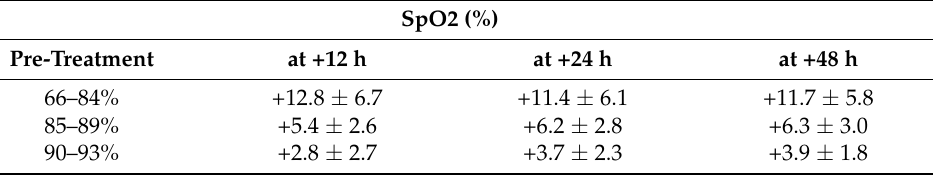
Figure 2. Pre- and post-treatment SpO2 values, all on room air, for 34 severe COVID-19 patients treated with IVM, doxycycline, and zinc. Graphs A–I are in horizontal groupings by the range of pre-treatment SpO2 values and in vertical groupings by elapsed time after first dose of IVM. (The lowest SpO2 value in the stipulated range of 51–93% was 66%.) For these elapsed times of x = 12, 24, and 48 h, the SpO2 value shown for a given patient is at the latest post-treatment time ≤ x . All pre-treatment SpO2 values are from within one hour before the start of treatment. Table 2. Mean ( ± SD) changes in SpO2 values from pre- to post-treatment with IVM-based combina- tion